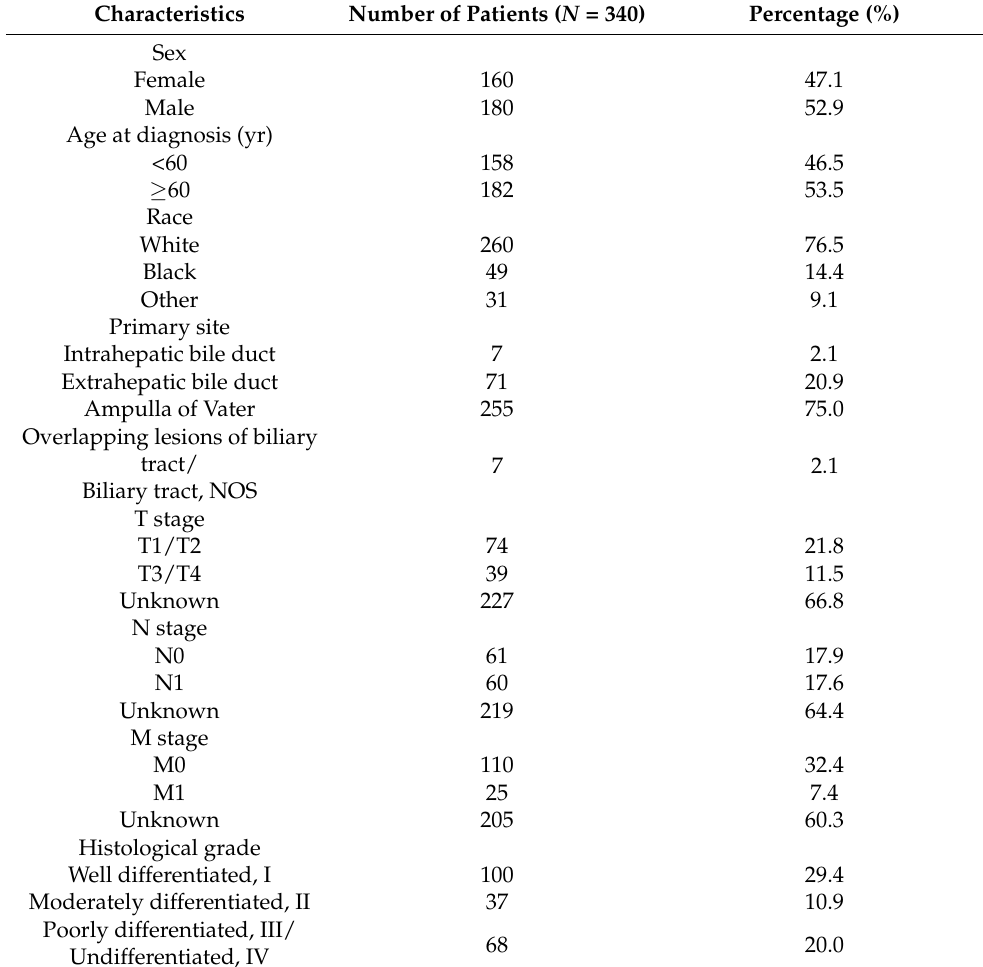
Table 1. Clinical characteristics of 340 patients with primary bile duct and ampullary neuroen- docrine